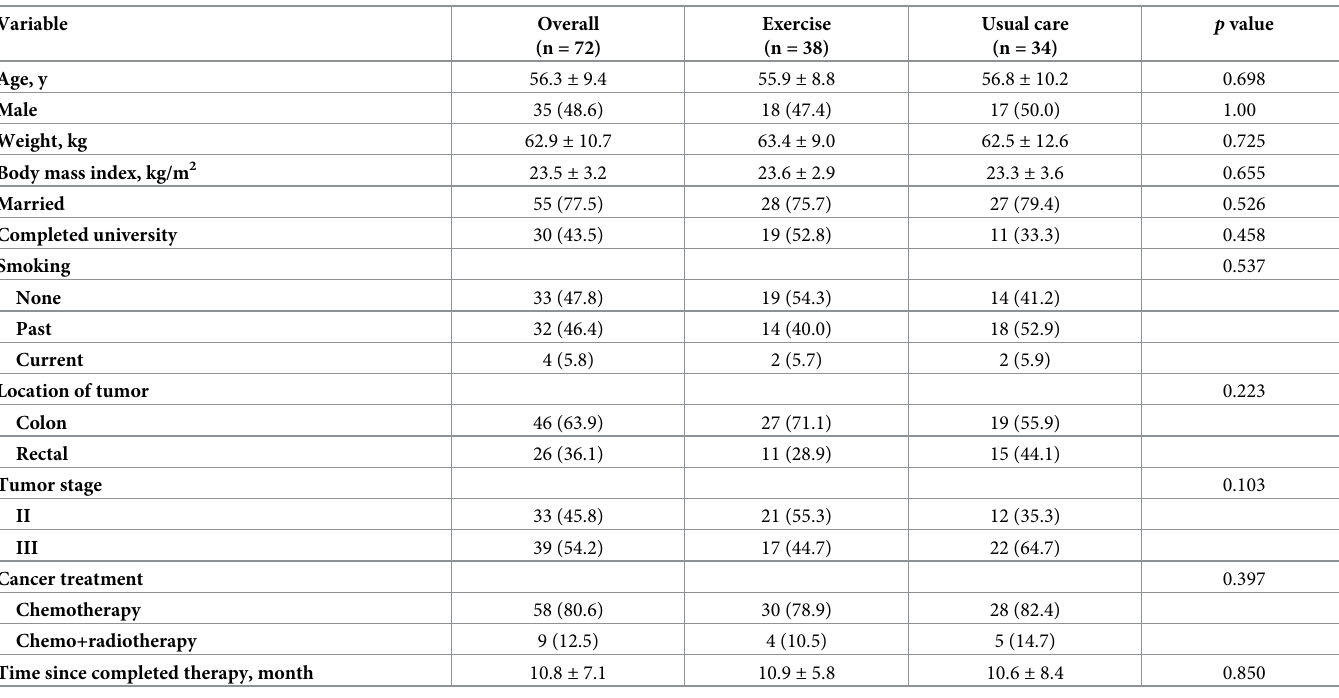
Table 1. Baseline demographics and medical profile of participants overall and by group assignment.